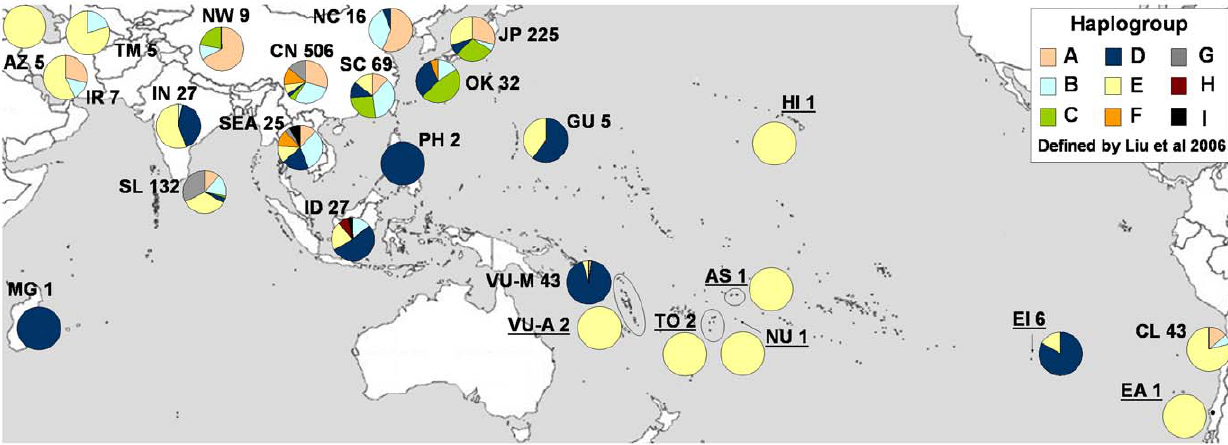
Figure 1. Frequency of chicken haplogroups by geographic location: sampling location followed by sample size. Reference, Accession Numbers: AS: American Samoa (8, EF535240); AZ: Azerbaijan (13, AY704696-700); CL: Chile (10, EF190830-70); CN: Central China – Guizhou, Guangxi, Henan, Hubei, Hunan, Jiangxi, Sichuan, and Yunnan provinces (13, AF512057-060, 062-179, 189-214, 234-254, 261-337, AY392172-407; 15, AB098664- 6; 16, AY465968-5975, 5988-6003; 17, AY588613-20, 29-35); EA: El-Arenal 1 (8, EF535241); EI: Easter Island (8, EF535242-7); GU: Guam (this study, FJ914362-6); HI: Hawaii (8, EF535238); ID: Indonesia (13, AY642127-33; 18, D82916-9; 19, AB007726, AB009436-40; 20, AB268525-28, 40, 45); IN: India (13, AY644966-73, AY704701-19); IR: Iran (13, AY704720-4; 19, AB009444; 21, FJ619040); JP: Japan (15, AB098636-39, 41-55, 57-63, 70-87, 89-95, 97-99; 18, D82921, 3, 5; 19, AB007722, 28-33, 35-41, 43-48, 50-51, 54-55, 58, AB009427-29, 46; 20, AB268506-24, 29-37, 39; 22, AB114058-86); MG: Madagascar (19, AB007742); NC: North Coastal China – Shandong and Liaoning provinces (16, AY465976-79, 84-87; 17, AY588621-8); NU: Niue (8, EF535239);